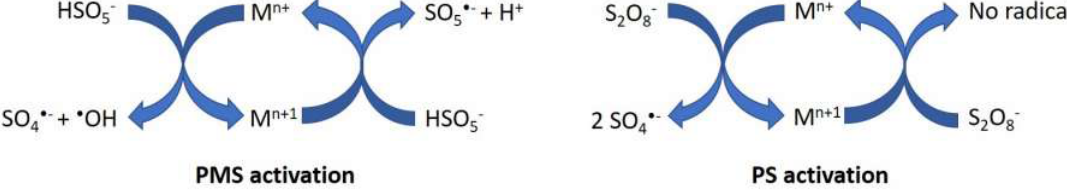
Figure 4. Transition metal-based catalytic activation of peroxymonosulfate (PMS) and persulfate (PS) [202].